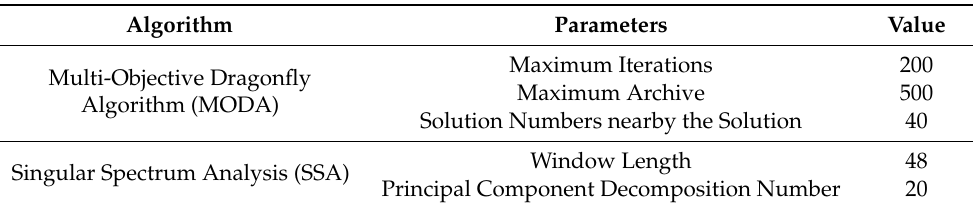
Table 2. Parameters in experiment